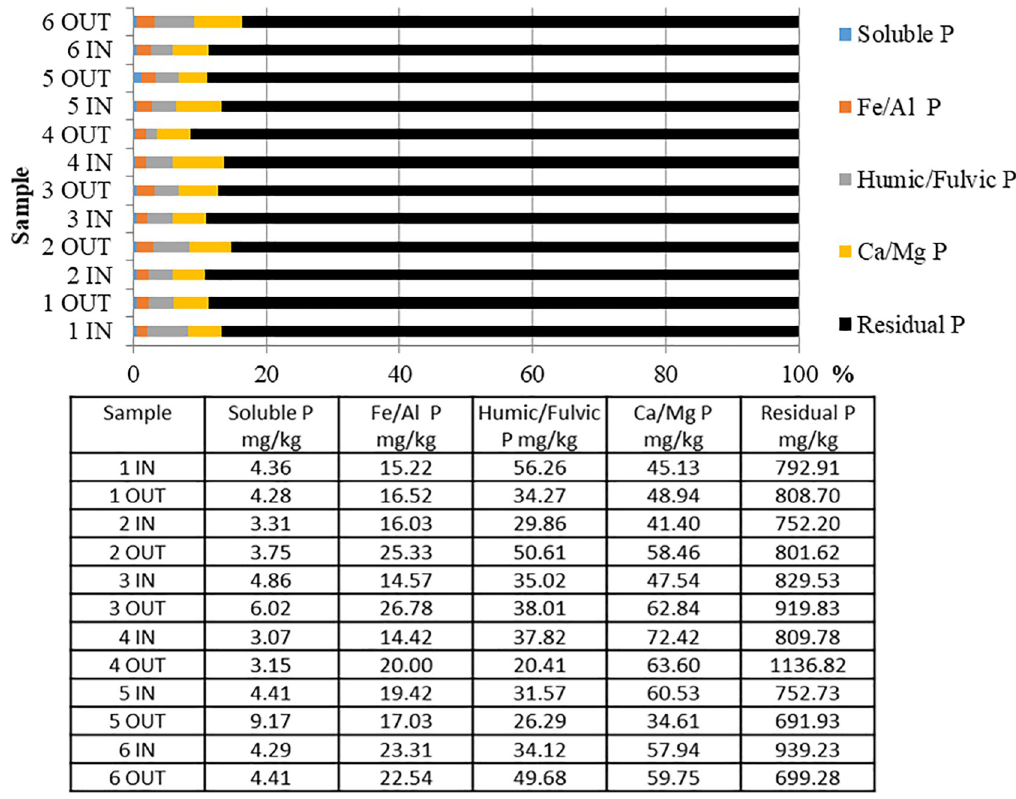
Fig 6. Results from modified Hedley (1982) phosphorus fractionation on a percentage basis (see horizontal bar chart above) and in mg kg -1